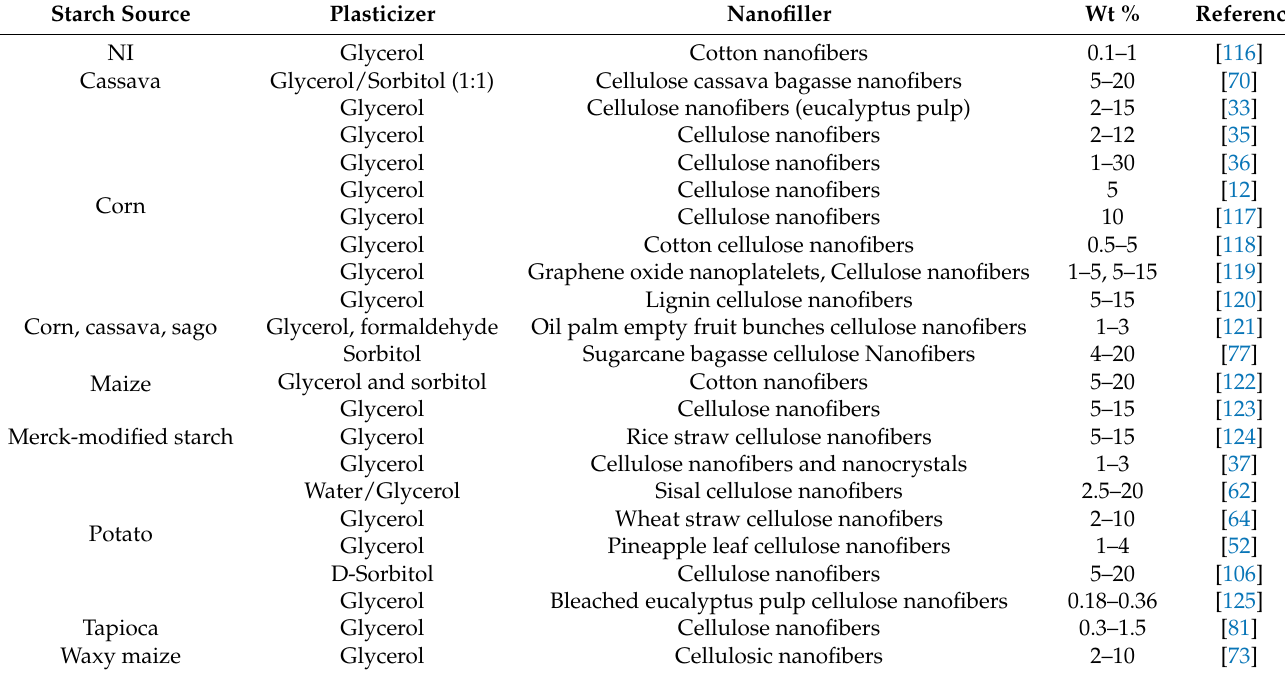
Table 1. Plasticizers and cellulose nanofibers as nanofillers (including their wt %) in most used TPS sources. Starch